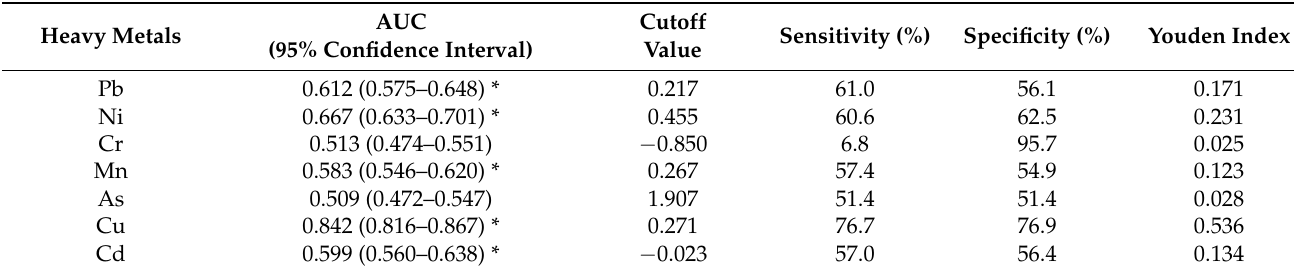
Table 5. Area under the curve (AUC), cutoff value, Youden index, and sensitivity and specificity of seven heavy metals for proteinuria.